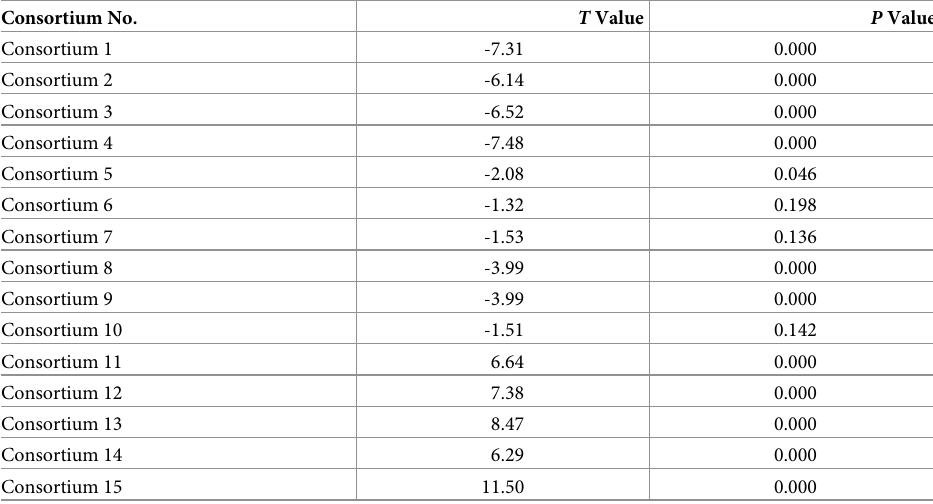
Table 8. ANOVA of fungal consortium producing manganese peroxidase. Consortium No.